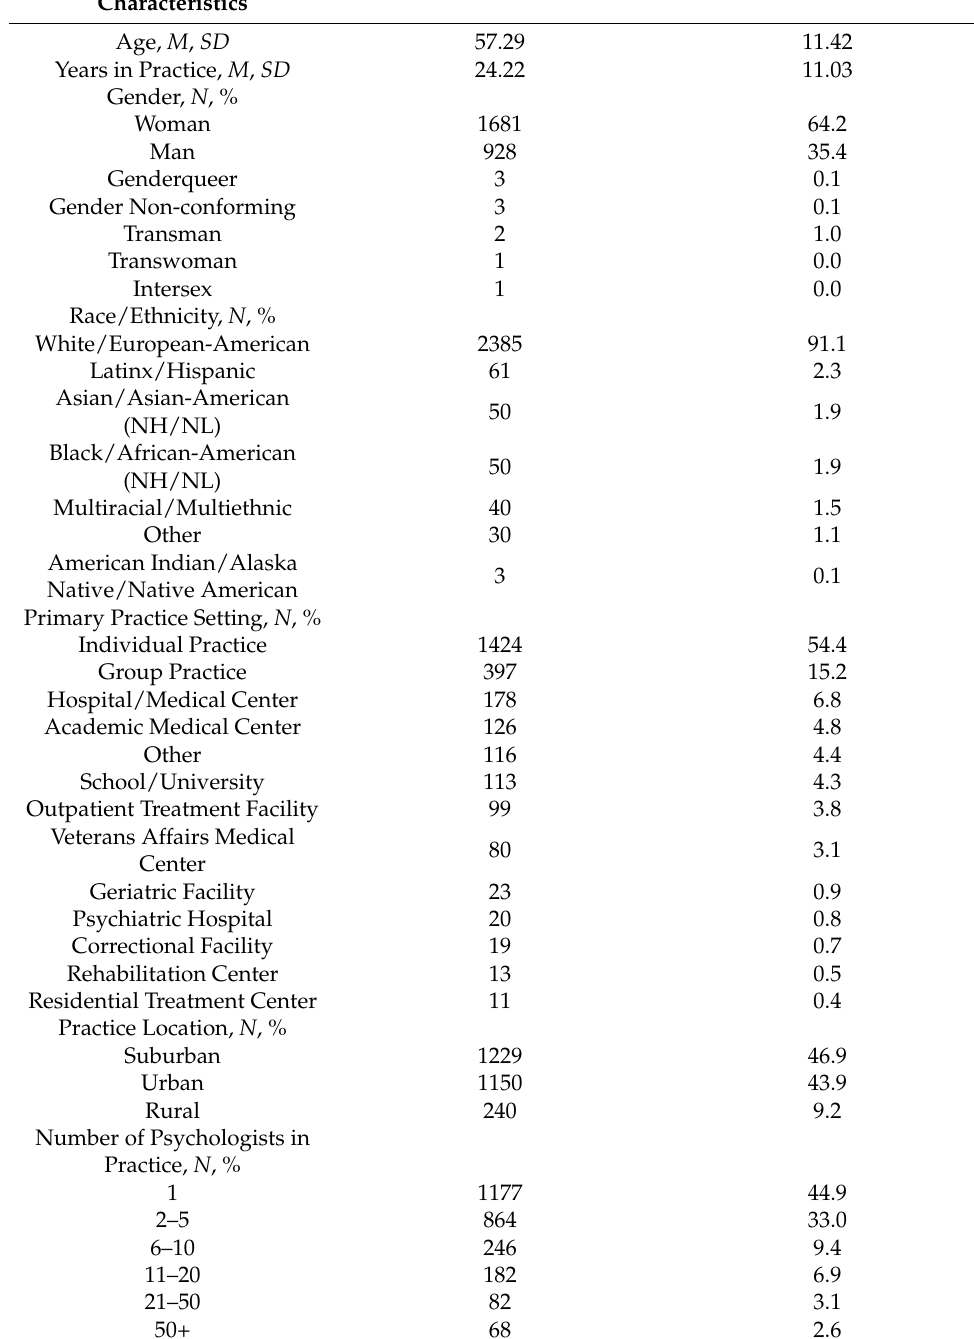
Table 1. Summary of Participant